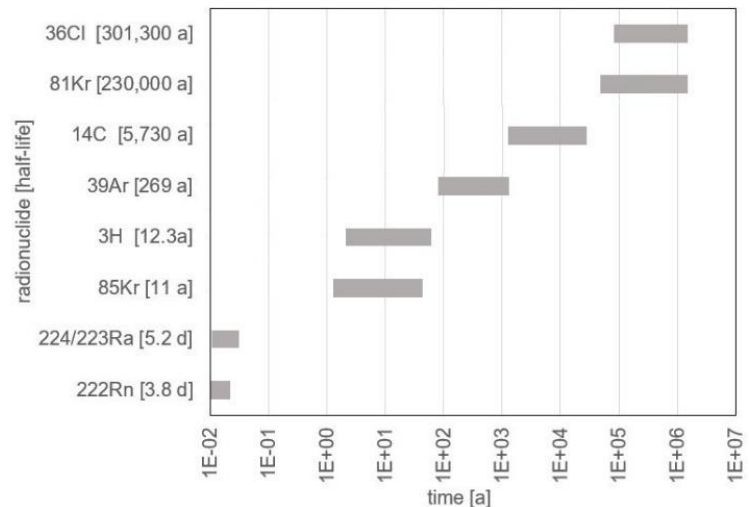
Figure 1. Naturally occurring radionuclides that are conventionally applied as aqueous residence time tracers plotted versus approximately covered residence time ranges.